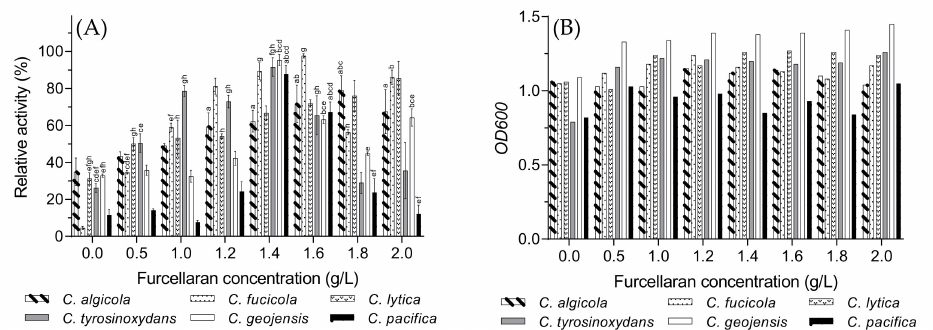
Figure 7. The effects of different furcellaran concentrations on the Cellulophaga species on ( A ) ι -carrageenase production and ( B ) cell growth of the Cellulophaga species presented as optical density ( OD 600 ). Values of Figure 7A are expressed as mean ± SEM (n = 4). Data comparison was performed against furcellaran concentrations. a = when compared with 0 g/L, b = when compared with 0.5 g/L, c = when compared with 1 g/L, d = when compared with 1.2 g/L, e = when compared with 1.8 g/L, f = when compared with 2.0 g/L. Different lowercase letters on the bars indicate statistically significant differences from respective group using ANOVA, followed by Tukey’s comparison test ( p <